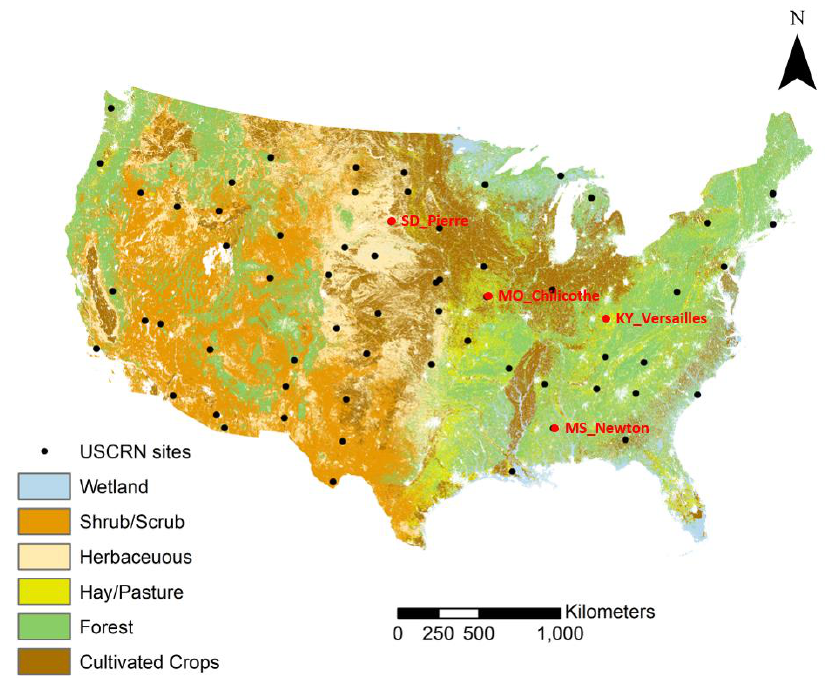
Figure 1. The U.S. Climate Reference Network (USCRN) stations used to retrieve surface soil moisture. The land cover map is obtained from the National Land Cover Database (https://www.mrlc.gov/data/type/land-cover). The red data points are the four USCRN stations of interest in this study.